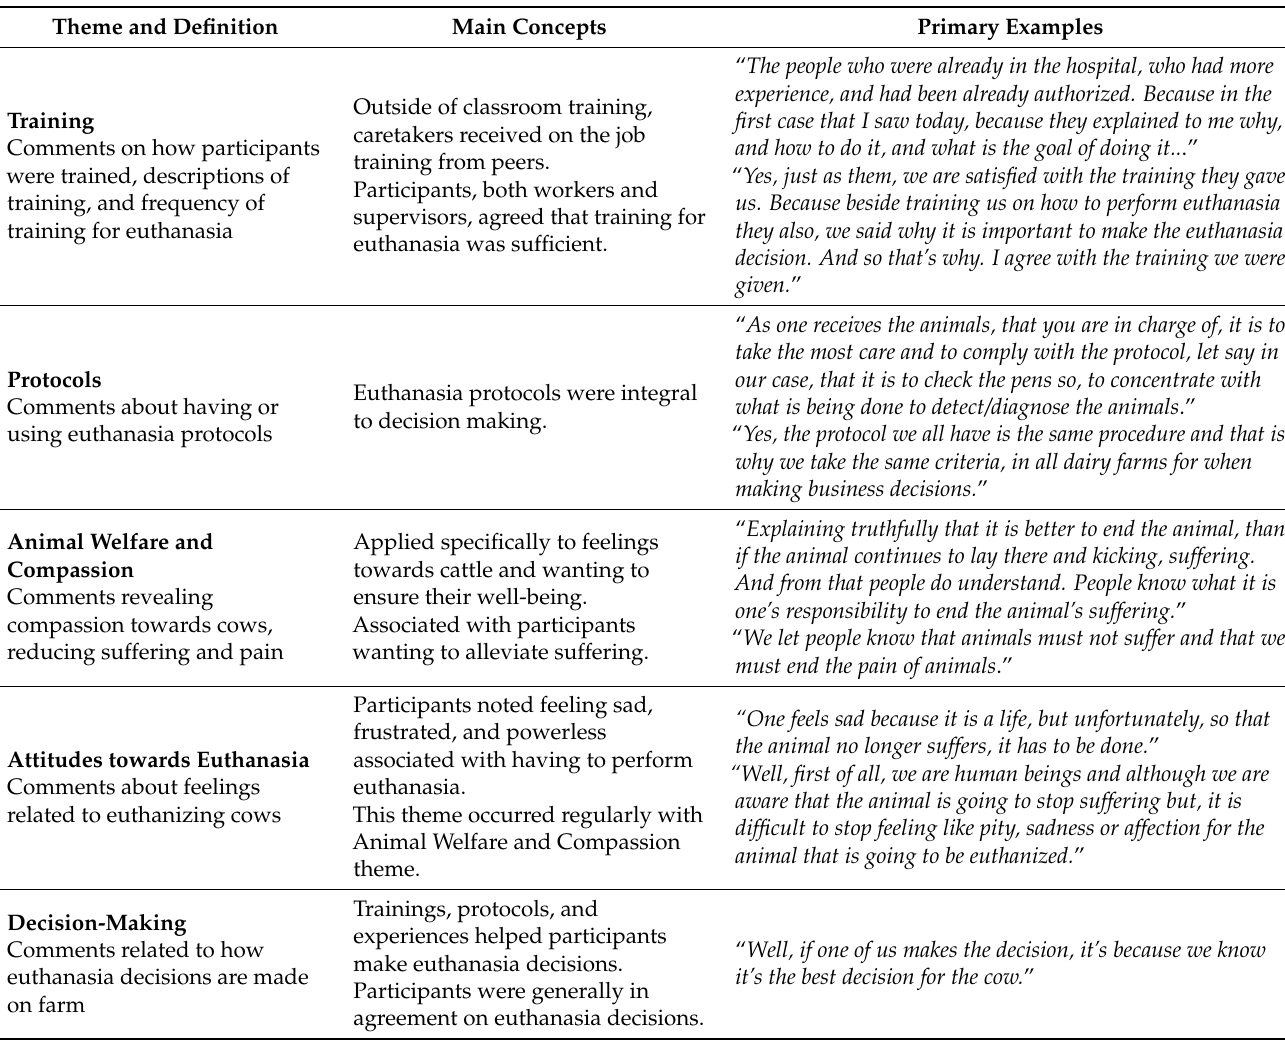
Table 2. Theme definitions, main concepts within each theme, and transcript excerpts for each